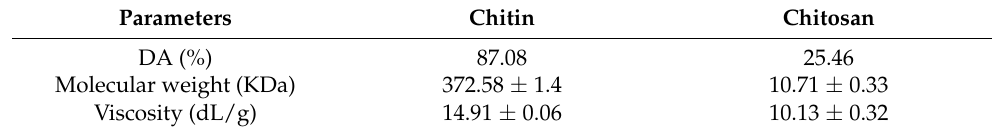
Table 2. Physical proprieties of chitin and chitosan extracted from Parapenaeus longirostris caught from the north of Tunisia. Values (g/100 g) are reported as dry mass ( ± : Standard Error).